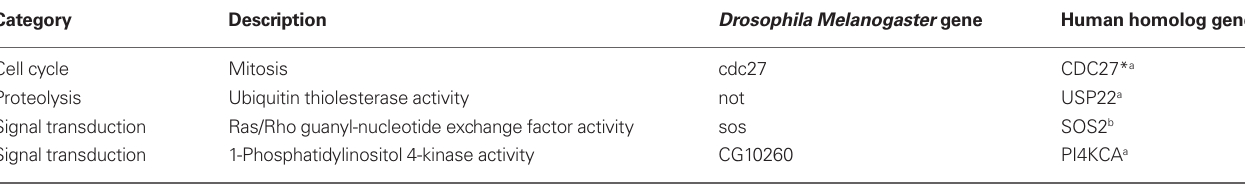
Table 2 | List of evolutionally conserved host factors involved in intracellular trafficking of F. tularensis in both D. melanogaster and human